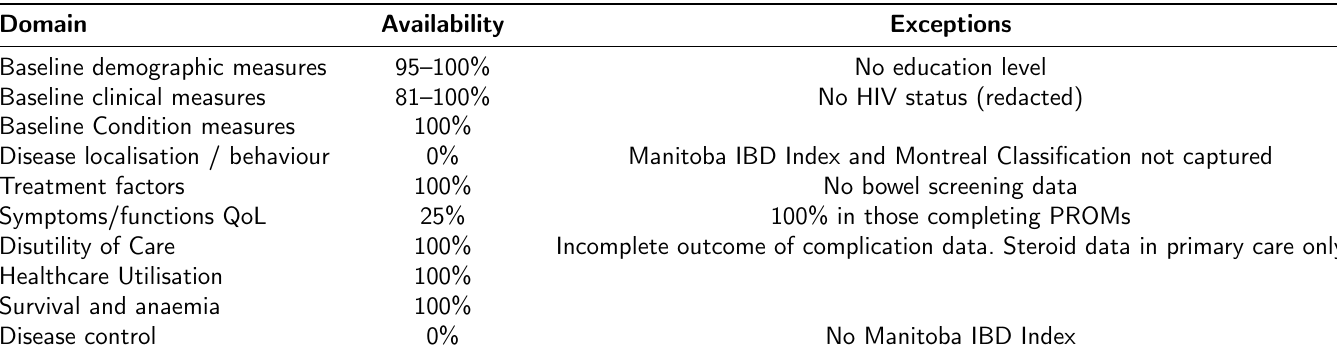
Table 2: Availability of data for patients in the BIO cohort. No data were available for any patient for Montreal Index, Educational Level, HIV status (redacted), Bowel cancer screening, and biologic disease activity/remission for any patients